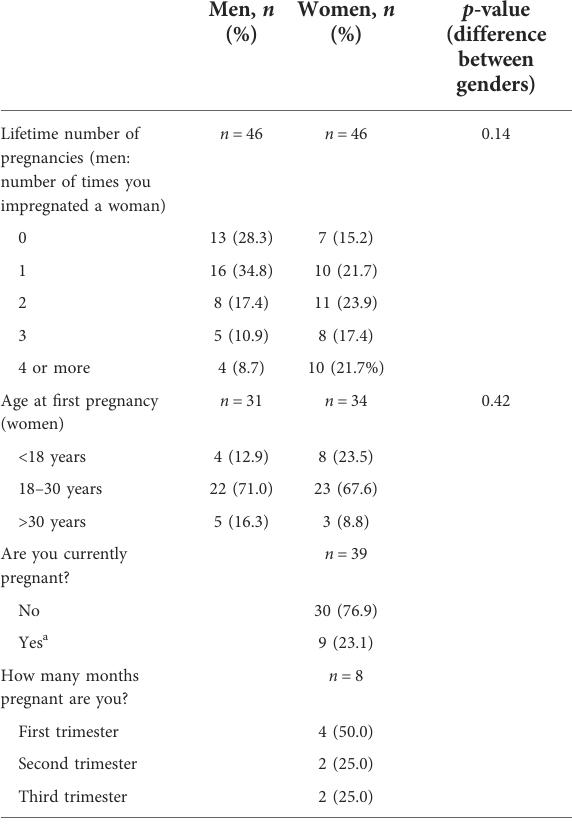
TABLE 5 Pregnancy (self-reported by adults age ≥ 18